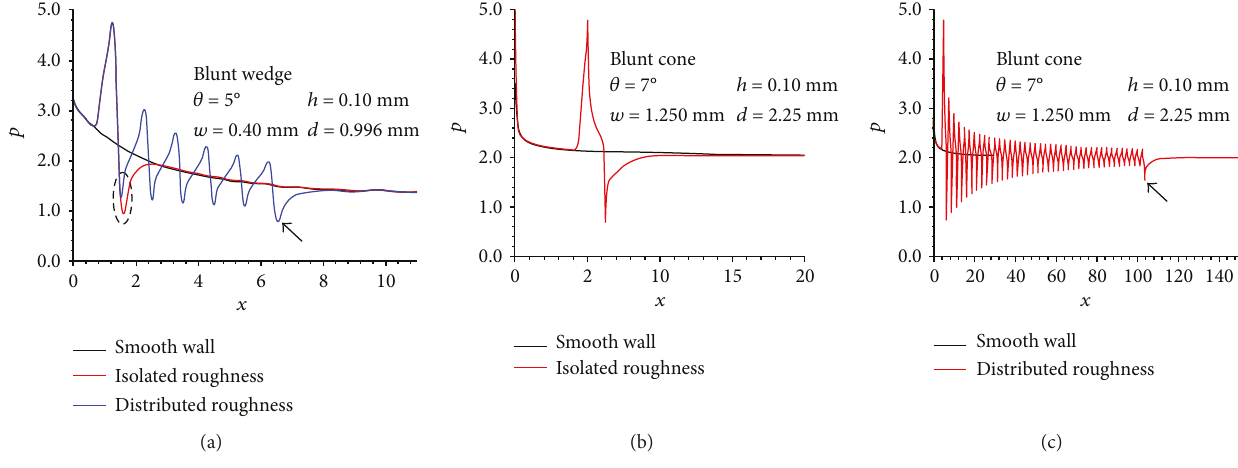
Figure 4: Comparison of distribution of wall pressure along the x -axis with the literature